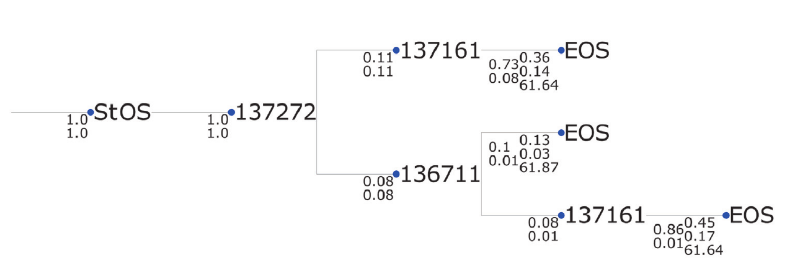
Figure 26: Output of the seq2probTree method for the HF production unit with input [137272].